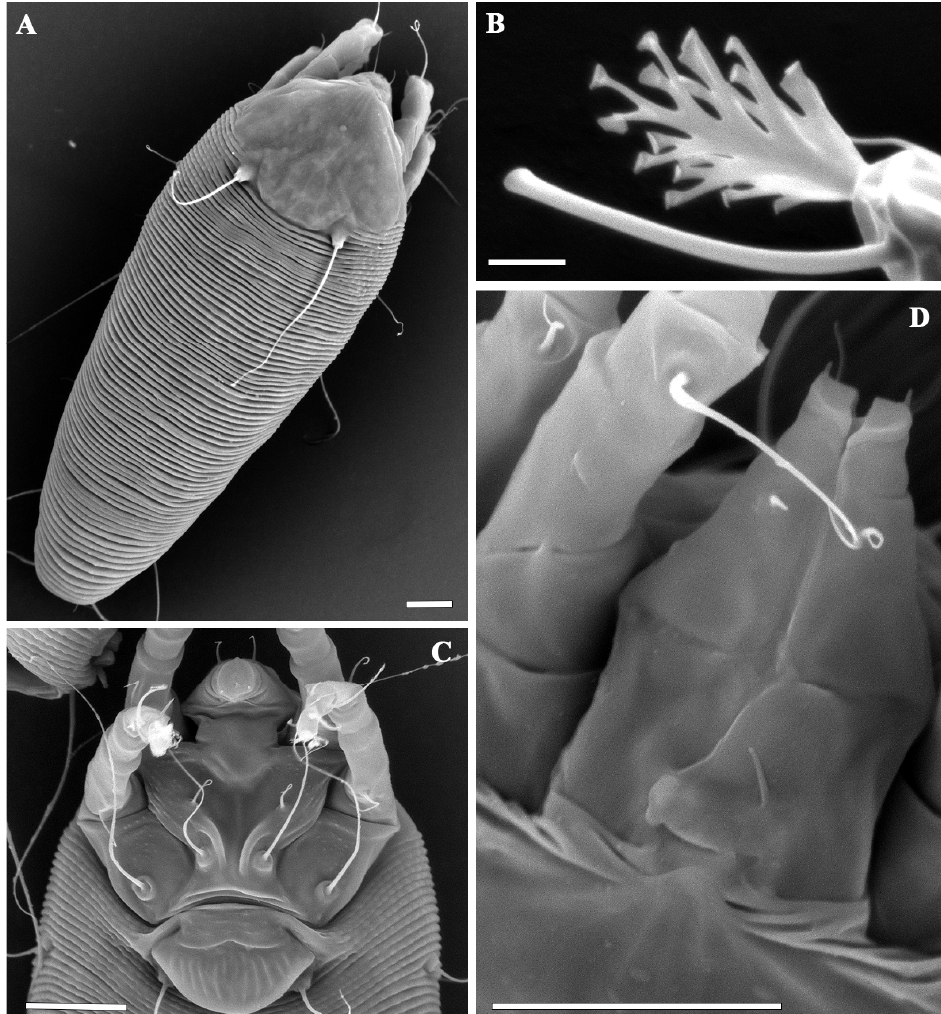
Figure 2. Scanning electron micrographs of deutogynes of Aculus mosoniensis : ( A ) dorsal view; ( B ) leg tarsal empodium and solenidion; ( C ) coxigenital region; ( D ) dorsal view of gnathosoma and frontal lobe. Scale bars: 10 μ m for ( A , B , D ); 2 μ m for ( B ).